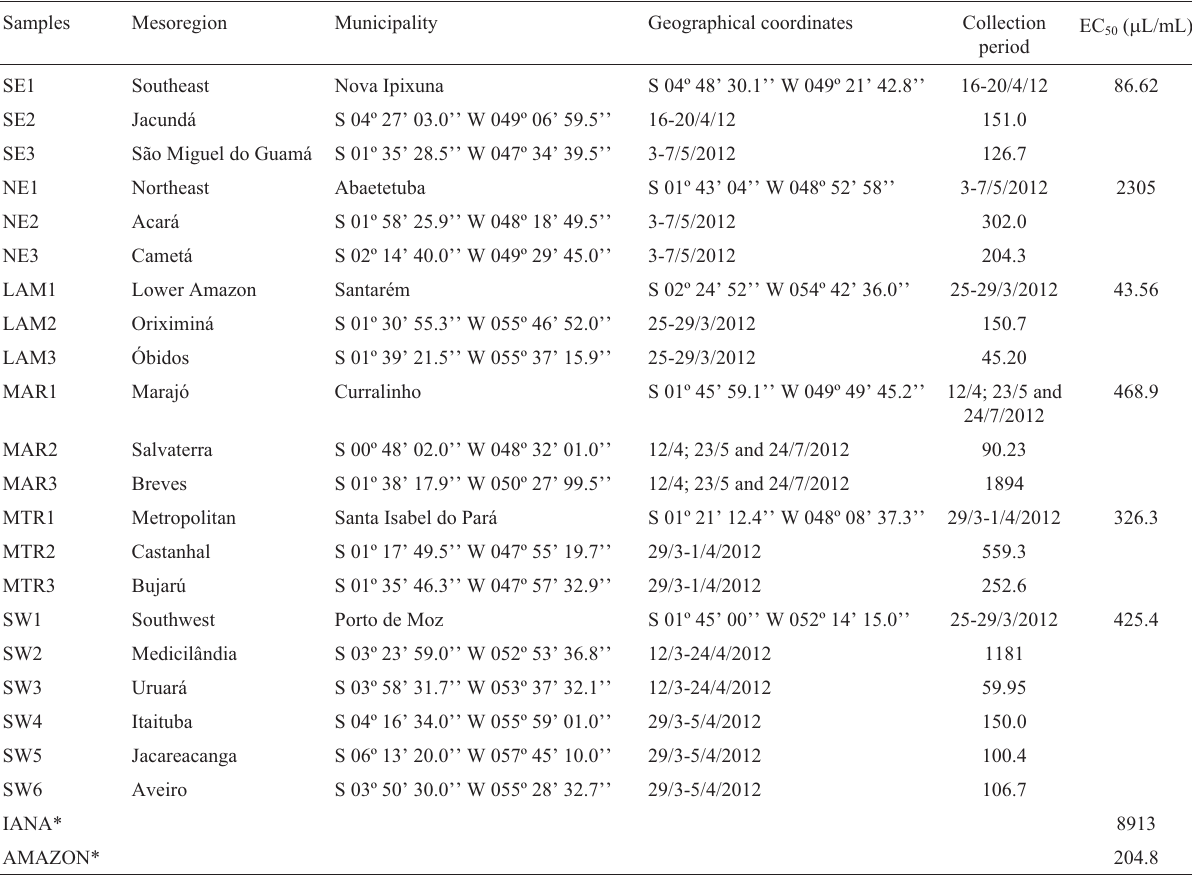
Table1 -Samples,localitiesandperiodsofcollectionofandirobaseedsandtheconcentrationofoilcausinga50%reductionintheDPPHradical(EC 50 ).